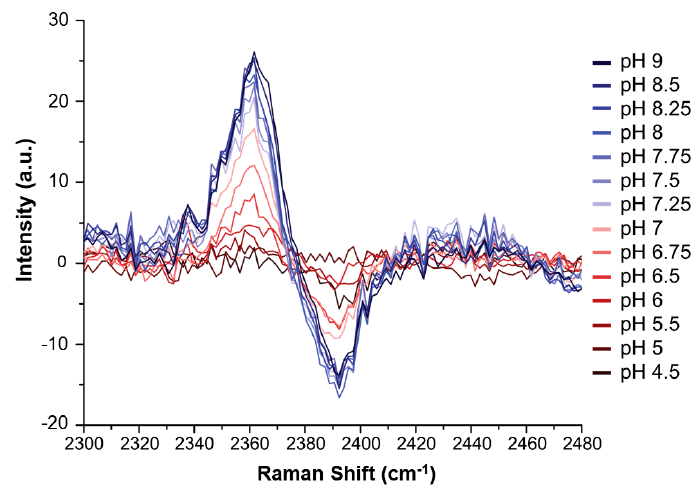
Figure 4. Raman difference spectra of H(C2-D)VD peptide at each pH value, versus the spectrum at pH 4. More basic samples (from red to blue) display stronger difference spectra up through pH 8.25 (thus indicating the end of the titration).